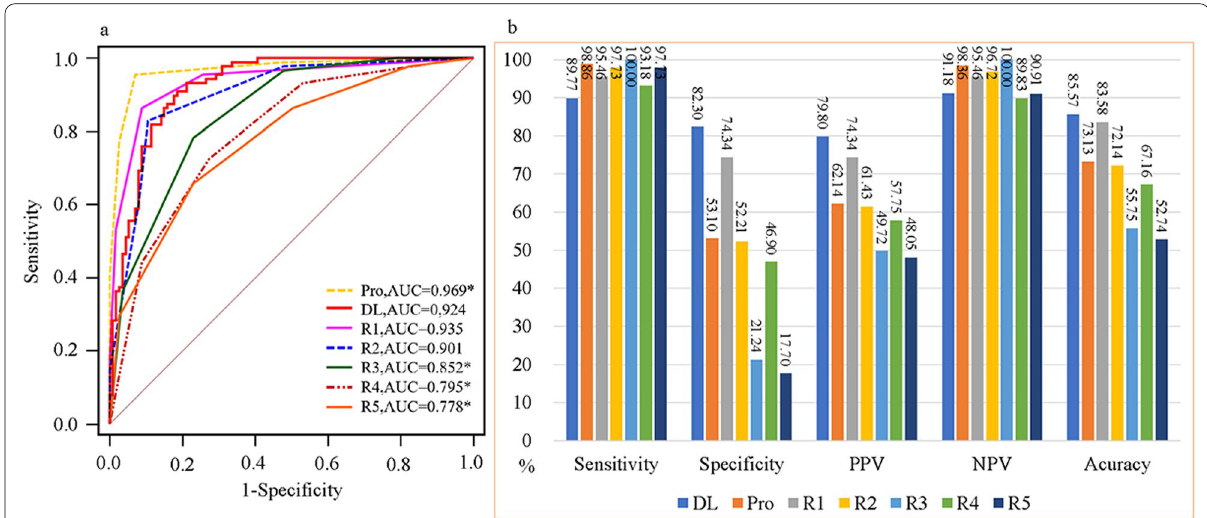
Fig. 3 Areas under the receiver operating characteristic curves (AUCs) of the model versus the prospective BI-RADS assessment and the five radiologists in the comparison set ( a ). Performance metrics for the DL model versus the prospective BI-RADS assessment and the five radiologists in the comparison set ( b ). AUC area under the receiver operating characteristic curve; DL deep learning model; Pro the prospective Breast Imaging Reporting and Data System (BI-RADS) assessment; R radiologist. *Comparison diagnostic performance with DL model and shows statistical